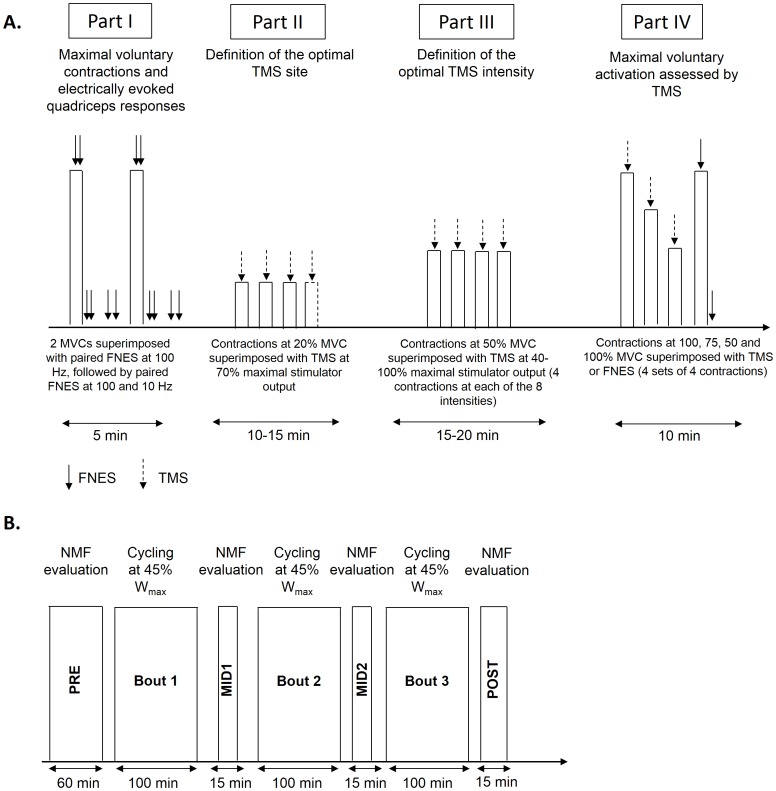
Overview of the neuromuscular function (NMF) evaluation (panel A) and the experimental protocol (panel B).NMF evaluation before exercise (PRE) consisted of four parts in the following order: Part I: MVC and electrically evoked quadriceps responses; Part II: determination of the optimal TMS site; Part III: determination of the optimal TMS intensity; Part IV: maximal voluntary activation with TMS. NMF consisted in part I and IV only after the first (MID1), the second (MID2) and the third (POST) bout of cycling.